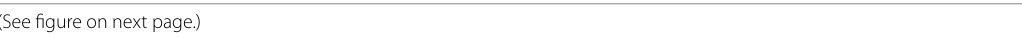
figure on next Fig. 6 Summary of detected pathogens. Number of positive samples for different pathogen species detected by mNGS in a 27 non SPF fecal samples (sample set A) and in b additional 15 non SPF fecal samples (sample set B). c Comparison between metagenomic data (dark gray bars) and results from health monitoring assays (light gray bars) employed for pathogens detection in all 42 non-SPF mice. x axis: number of samples positive for the indicated pathogen. y axis: pathogen species. All data were confirmed by PCR and